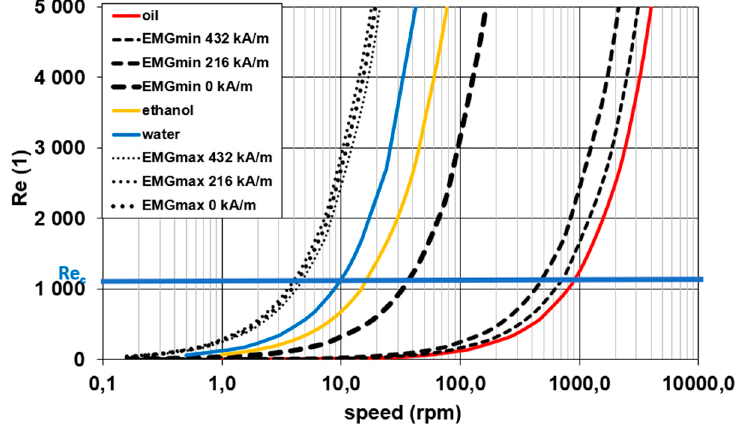
Figure 5. Taylor number vs. speed for oil, ethanol, water and EMG 900 (Ta c = 41).